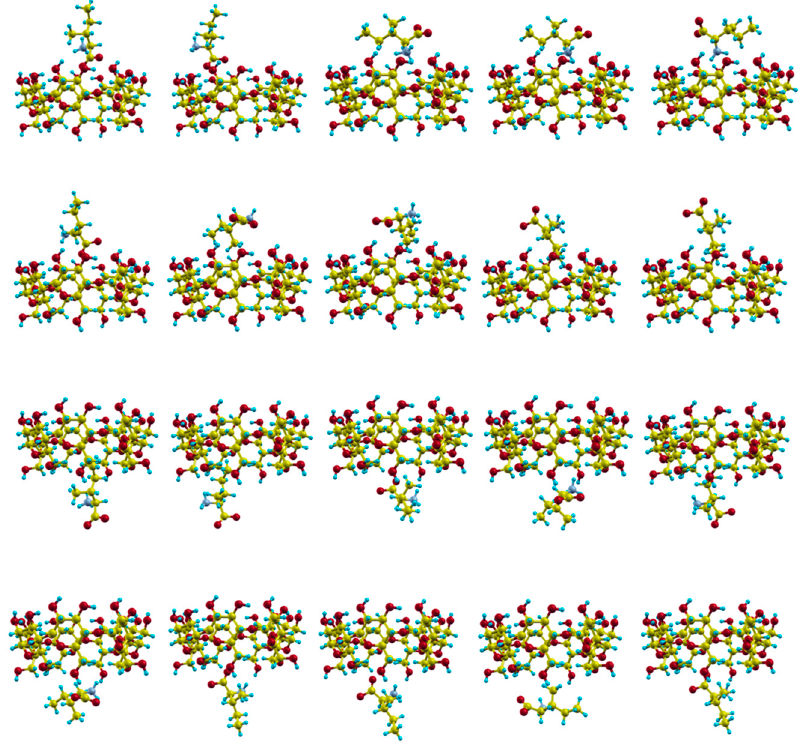
Figure 4. The initial centre of mass positions and orientations for the amino acid in the trajectories.